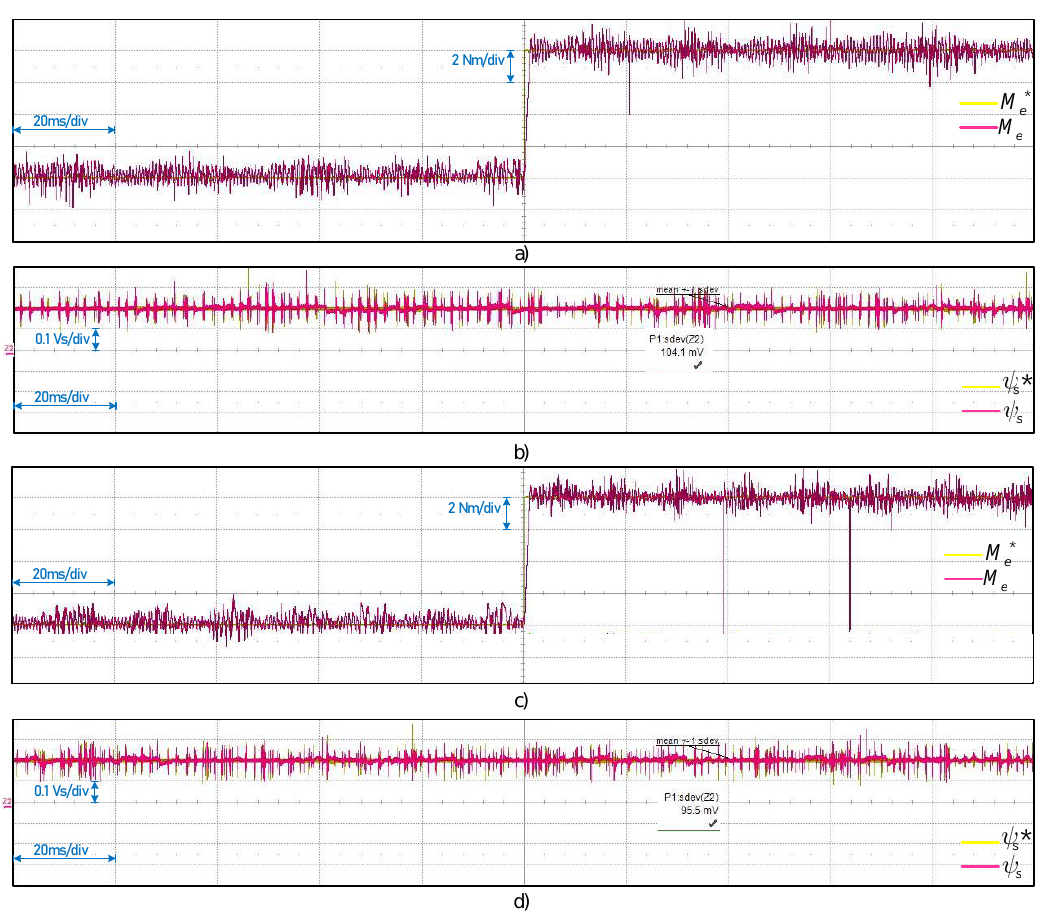
Figure 7. Dynamic state experimental results. ( a ) Electromagnetic torque conventional deadbeat control. ( b ) Stator flux conventional deadbeat control. ( c ) Electromagnetic torque proposed deadbeat control. ( d ) Stator flux proposed deadbeat